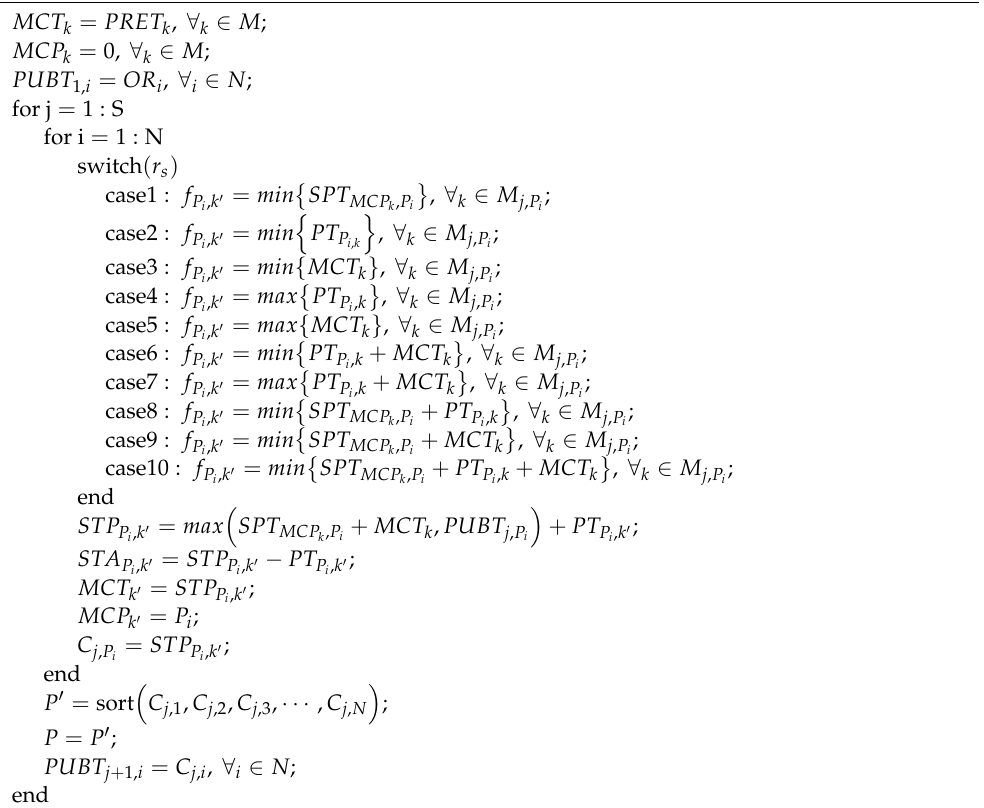
Algorithm 1: Job-machine assignment